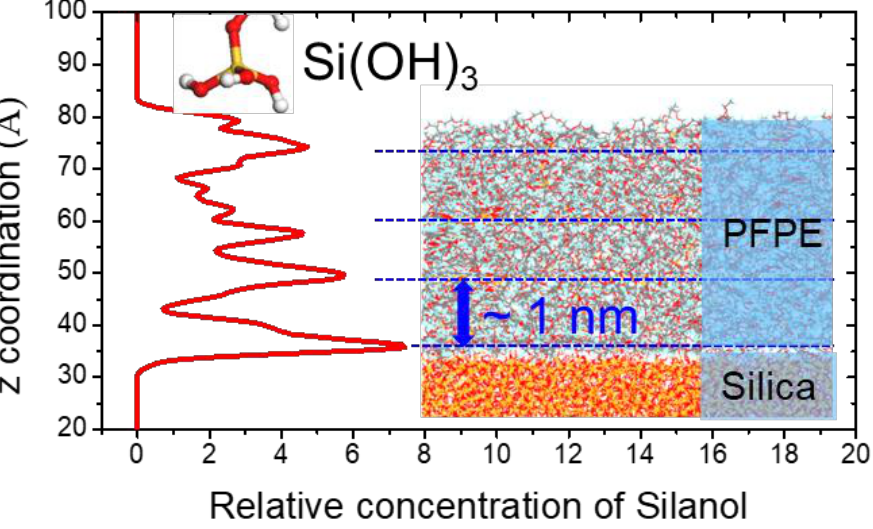
Figure 11. Concentration profile of silanol of SPFPE along with z -axis on silica surface (adapted with permission from Reference [30], Copyright 2019 American Chemical Society).